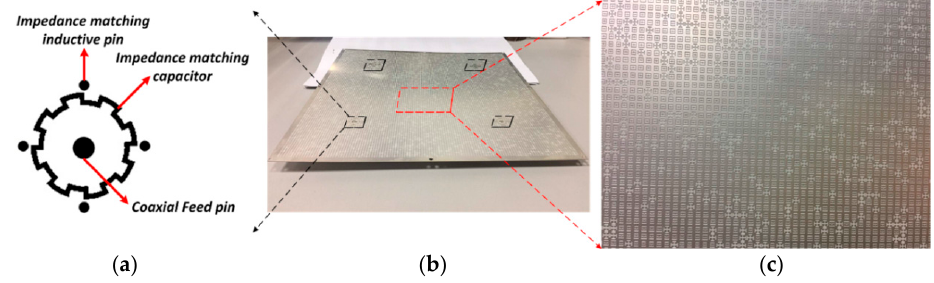
Figure 8. Geometry of the fabricated MAA: ( a ) feed structure (the black capacitor part is dielectric, and the remaining part is copper); ( b ) total view; ( c ) local view.